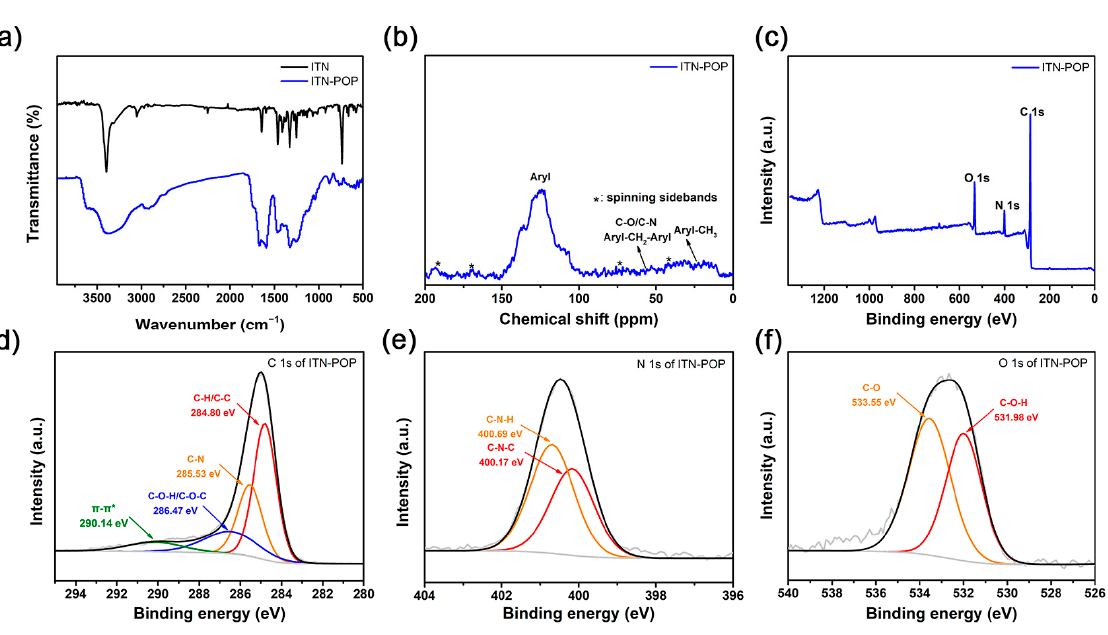
Figure 1. ( a ) FT-IR spectrum of ITN and ITN-POP; ( b ) Solid-state 13 C CP/MAS NMR spectrum of ITN-POP; ( c ) XPS survey scan of ITN-POP; ( d ) C 1s of ITN-POP; ( e ) N 1s of ITN-POP; ( f ) O 1s of ITN-POP.